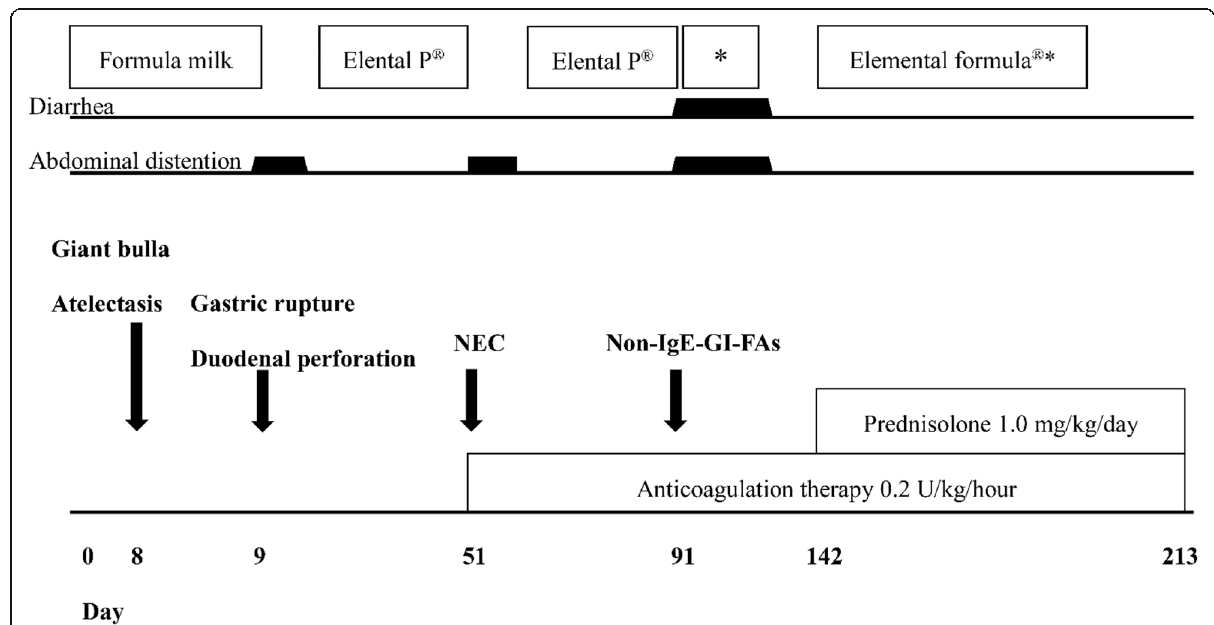
Fig. 4 Clinical course and management of recurrent intestinal ischemia. Clinical course and management of recurrent intestinal ischemia in an extremely low birth weight